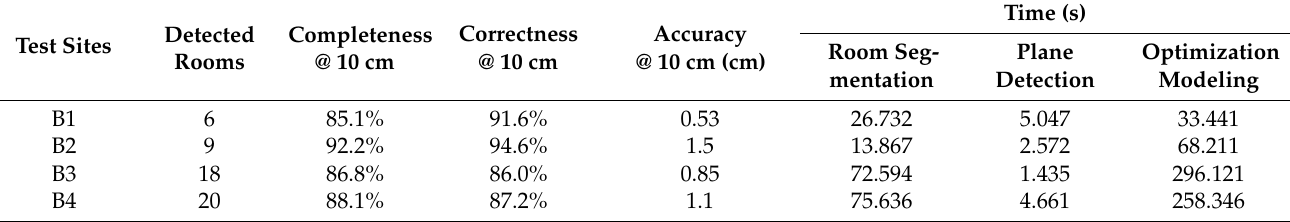
Table 7. Evaluation results for mesh